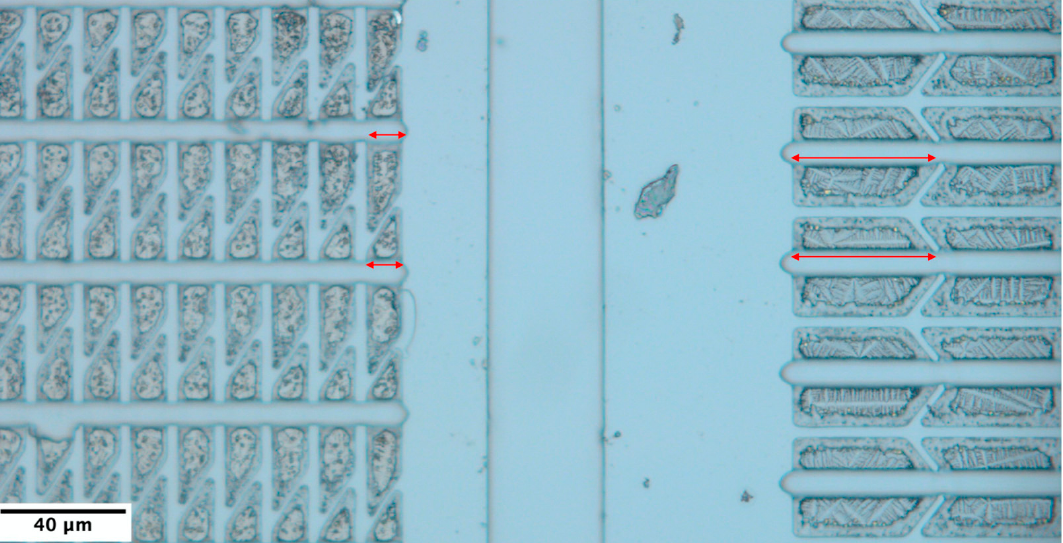
Figure 2. Plan-view optical micrograph of the sample after the removal of the SiO 2 /Si 3 N 4 capping layer and then the Au species, with small (vertical trapezoids, left ) and large (horizontal trapezoids, right ) micro-crucible openings. Different residual micro- and nanostructures can be observed from these two different geometries. The red double arrows indicate where the openings were located.